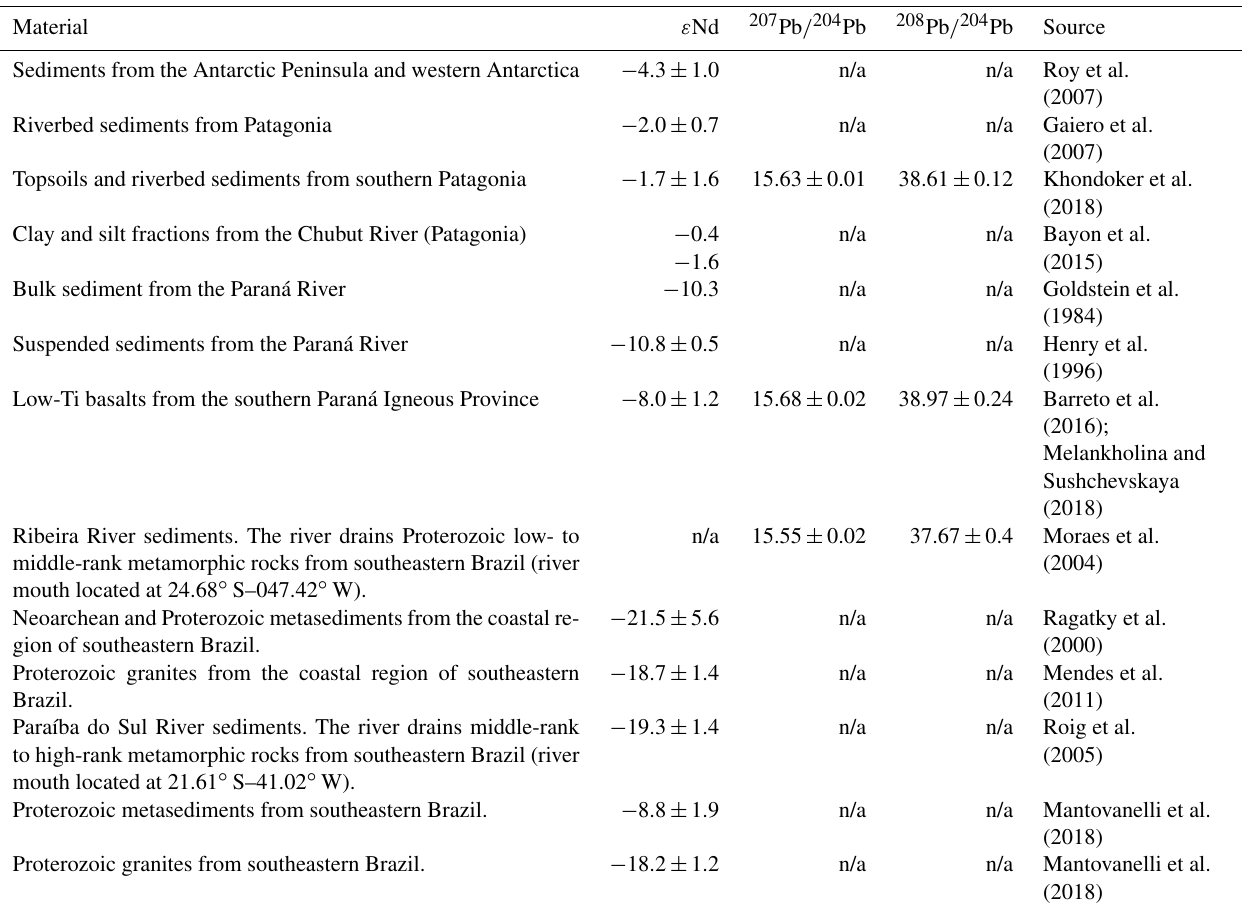
Table 2. Nd and Pb isotopic values of distinct continental materials from Antarctica and southeastern South America. Material ε Nd